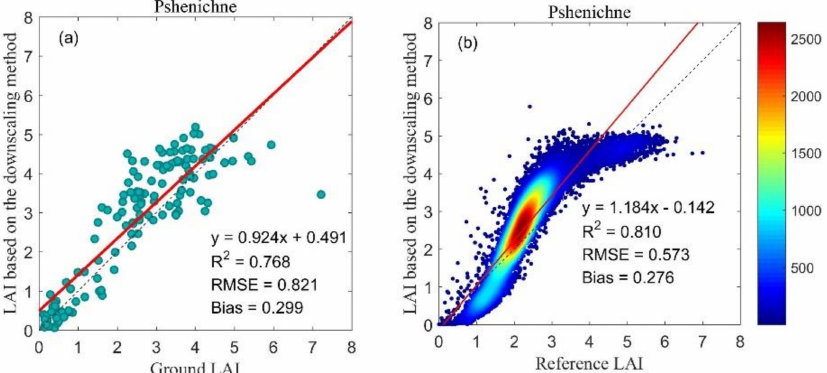
Figure 8. Evaluation of the fine-resolution LAI based on the model-downscaling method proposed in this paper at the Pshenichne site. ( a ) Ground LAI measurements; ( b ) the reference LAI map with 30 m spatial resolution obtained from the ImagineS project.